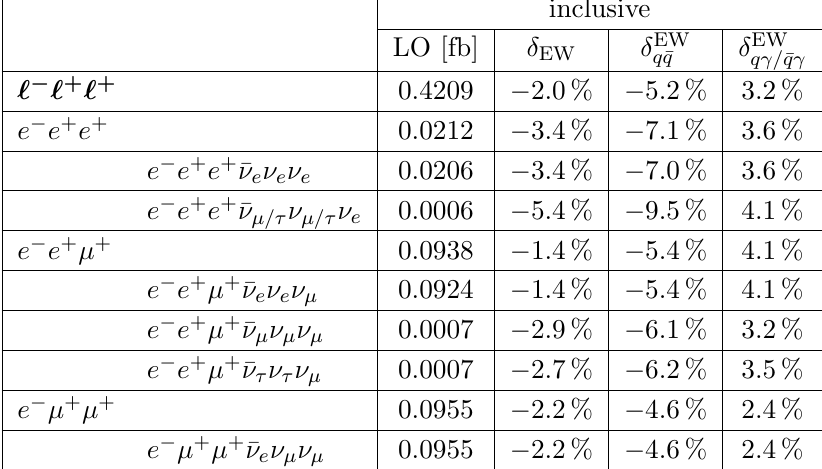
(cid:22) (cid:6) throughout, cf. $